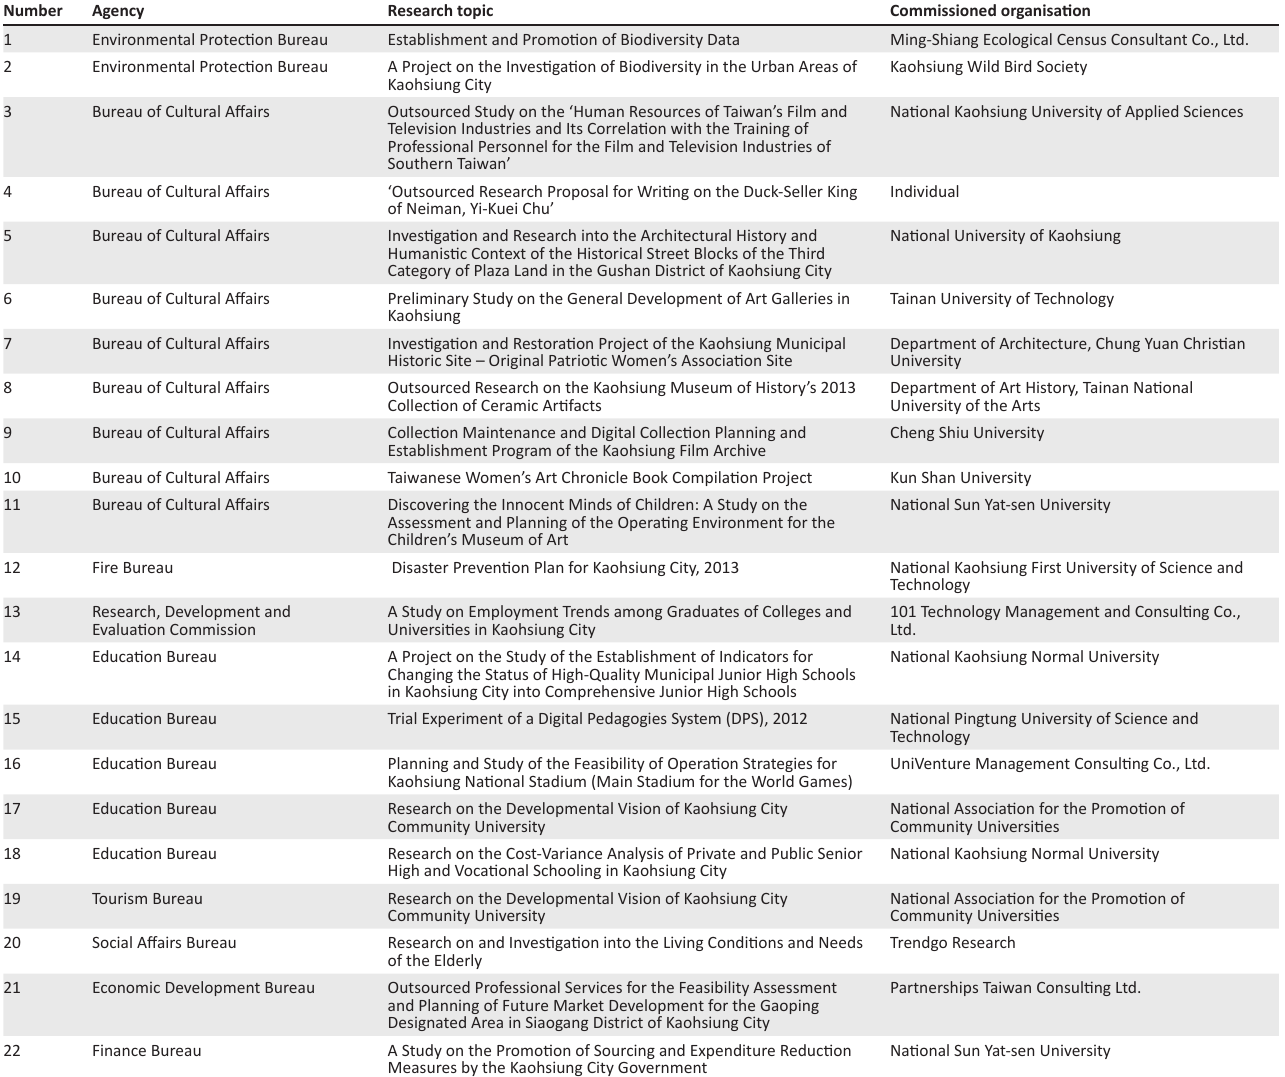
TABLE 1: Research projects outsourced by Kaohsiung City Government agencies,